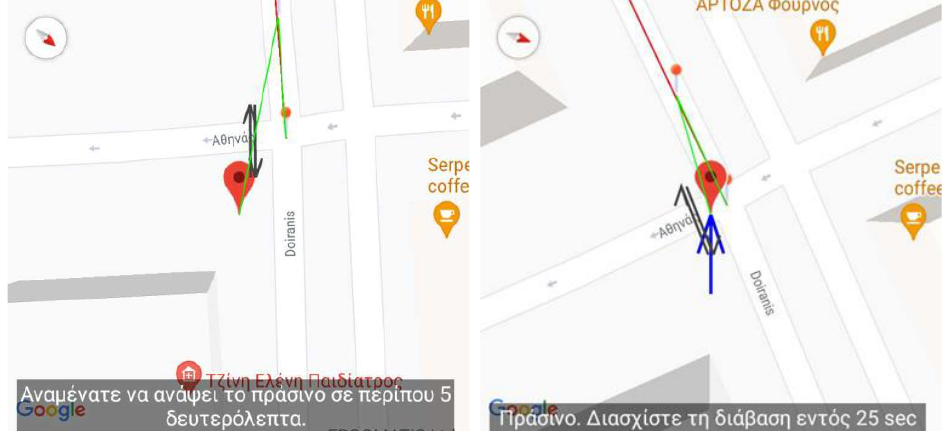
Figure 8. ( Right and left ). Passing traffic lights crossings with safety—text in left figure: “Five seconds remaining for the traffic light to turn green”; Text in right figure: “Traffic light turned green. 25 s remaining to